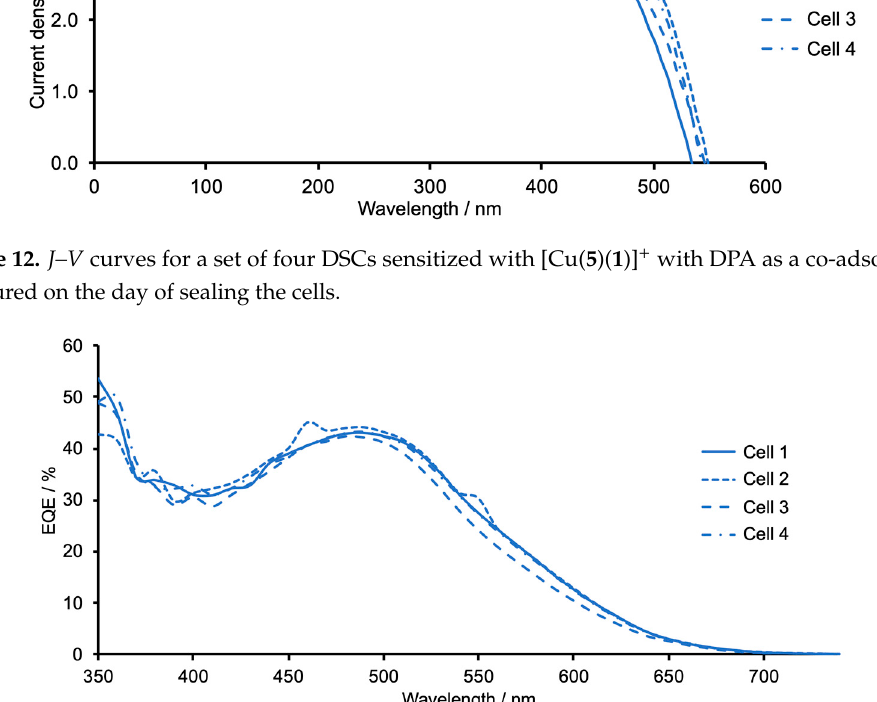
Figure 14. Equivalent circuit used to fit the electrochemical impedance spectroscopy (EIS) data, where R s is the series resistance, R Pt and CPE1 are the resistance and constant phase element of the platinum